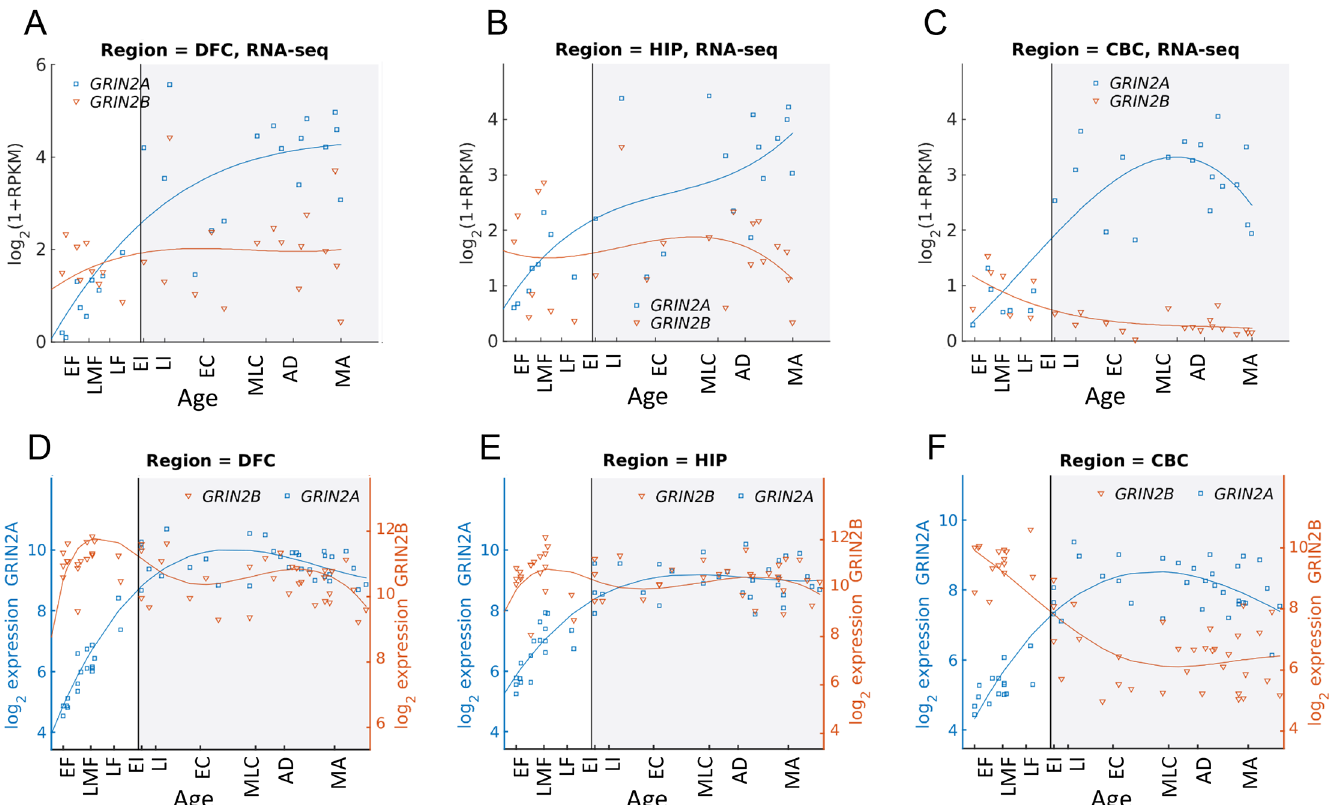
Fig 6. Timing and spatial differences of the NR2A/2B developmental switch. In human cortex (RNA-seq:A, microarrays: D) and Hippocampus (RNA- seq: B; microarrays: E) childhood expression level of NR2B exhibit little significant change, and NR2A may be rising slowly. In the cerebellum (RNA-seq: C; microarrays: F), a more significant switch is observed. In all cases, the largest changes in expression levels occur before birth, and much smaller changes are observed